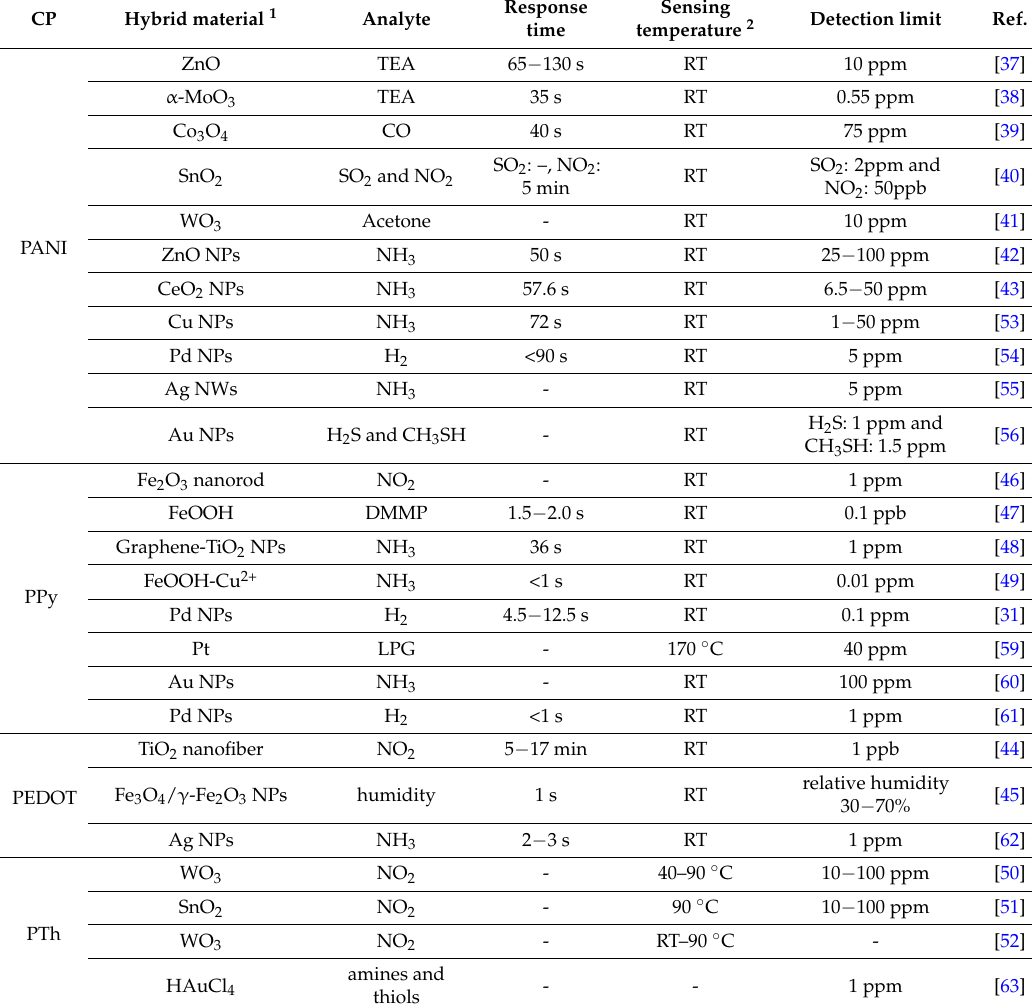
Table 1. CP inorganic hybrid composites used in gas